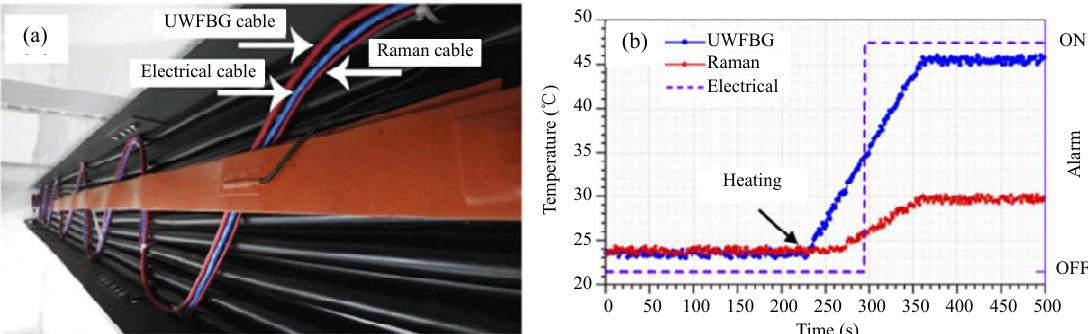
Fig. 6 Comparison experiment on the performance of three hot spot detection systems: (a) three kinds of cables are installed side by side on the test bench and (b) the experimental results [42].